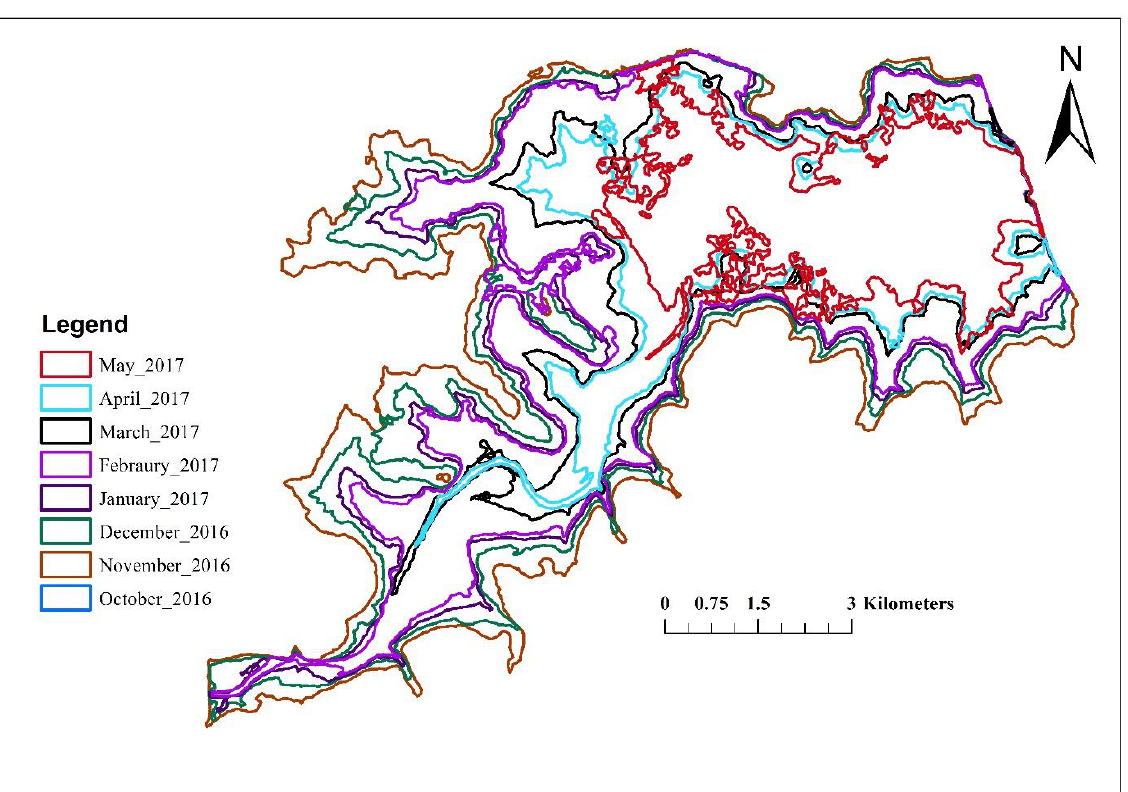
Figure 6. The change in water spread area of the reservoir during water year 2016-17 extracted from Sentinel-1